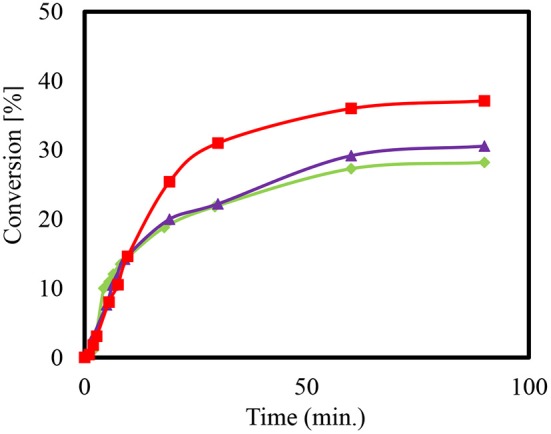
Conversion (%) to Solketal using HZSM-5 with different ratio (SiO2/Al2O3); 35 (), 90 (), and 160 (), at reaction temperature 50°C.